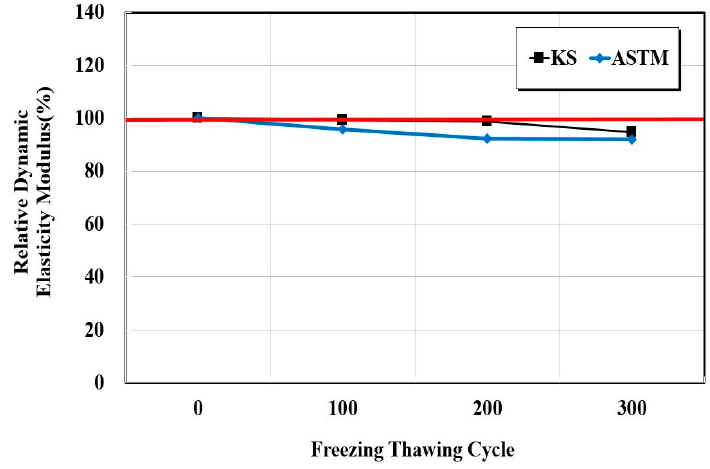
Figure 4. Relative dynamic elastic modulus test results as a function of the freezing–thawing cycle.